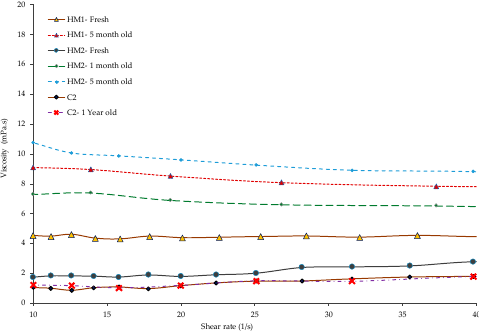
Figure 7. Viscosity vs. shear rate of the two homemade suspensions HM1 and HM2 aged for one, three, and five months compared with fresh suspensions.